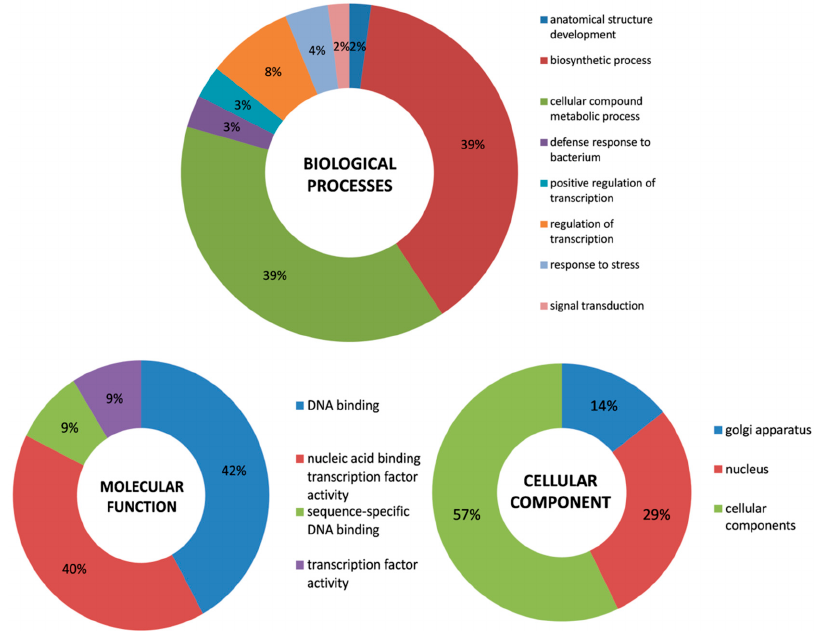
Figure 5. Functional annotation of the 94 WRKY proteins in pigeonpea. Distribution of functionally annotated genes in three main categories of GO classification viz. Biological processes, Molecular Function, and Cellular components.